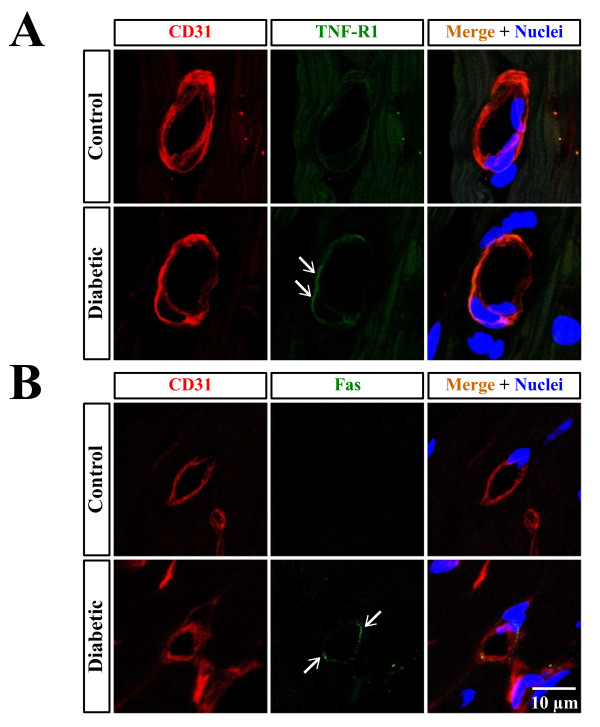
Immunofluorescent images for TNF-R1 (A) and Fas (B) (green, white arrows) in the left ventricular cross-sections from control and nicotinamide-streptozotocin-induced diabetic mice. Coronary arterial endothelial cells are stained with anti-CD31 antibody (red). Overlap images indicate that both TNF-R1 and Fas are present on coronary arterial endothelial cells. Nuclei were counterstained with Hoechst (blue). Shown are representative micrographs from two independent experiments in which the same results were obtained.